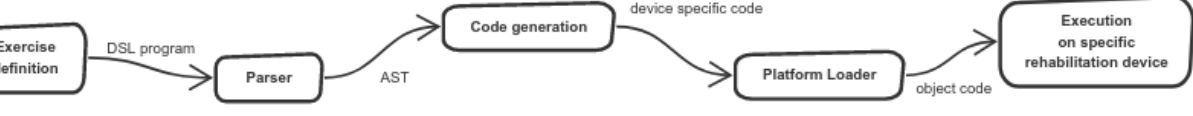
Figure 3. Language processing in